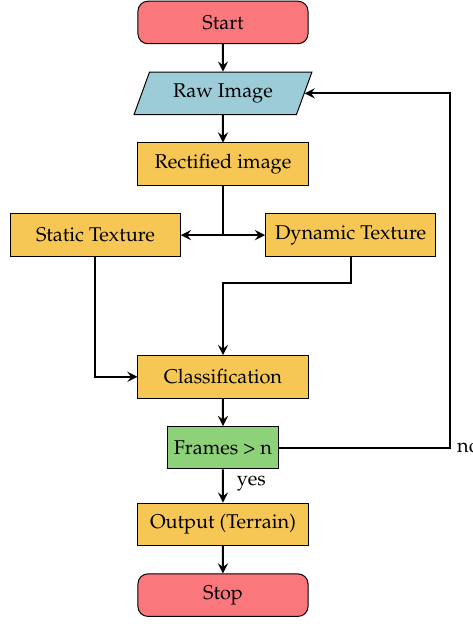
Figure 5. Proposed system